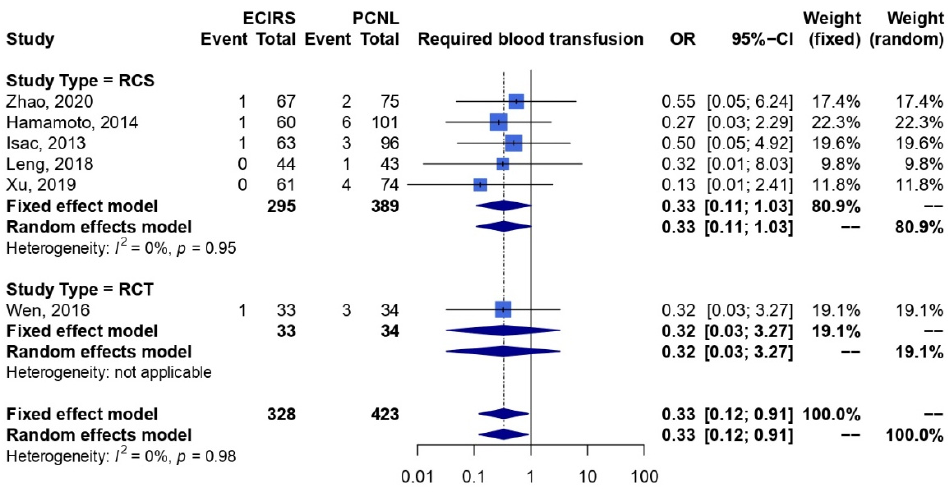
Figure A16. Subgroup analysis of outcome regarding required blood transfusion. (RCS: [18,19,21–23]; RCT: [17]).